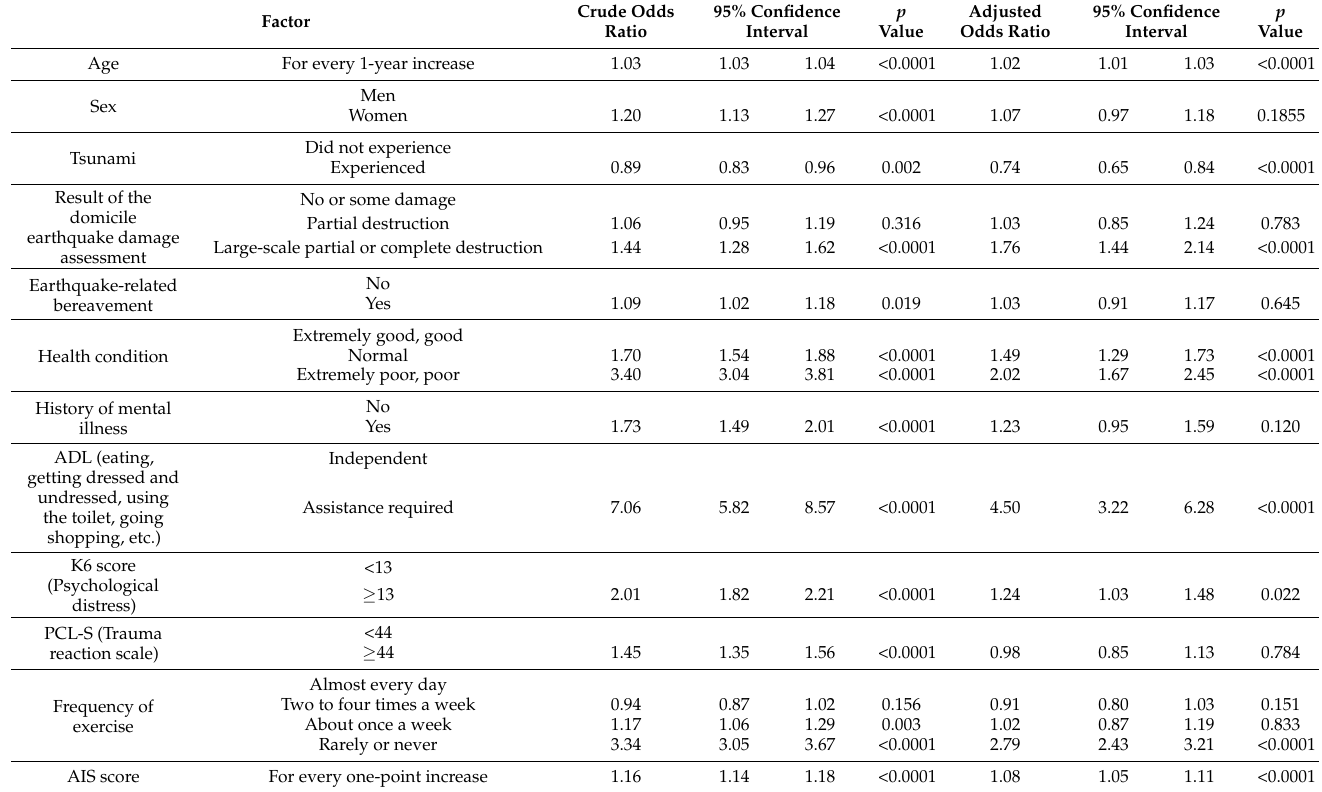
Table 3. Logistic regression analysis of the dependent variables for social nonparticipation among evacuees who relocated to areas within the Fukushima prefecture.